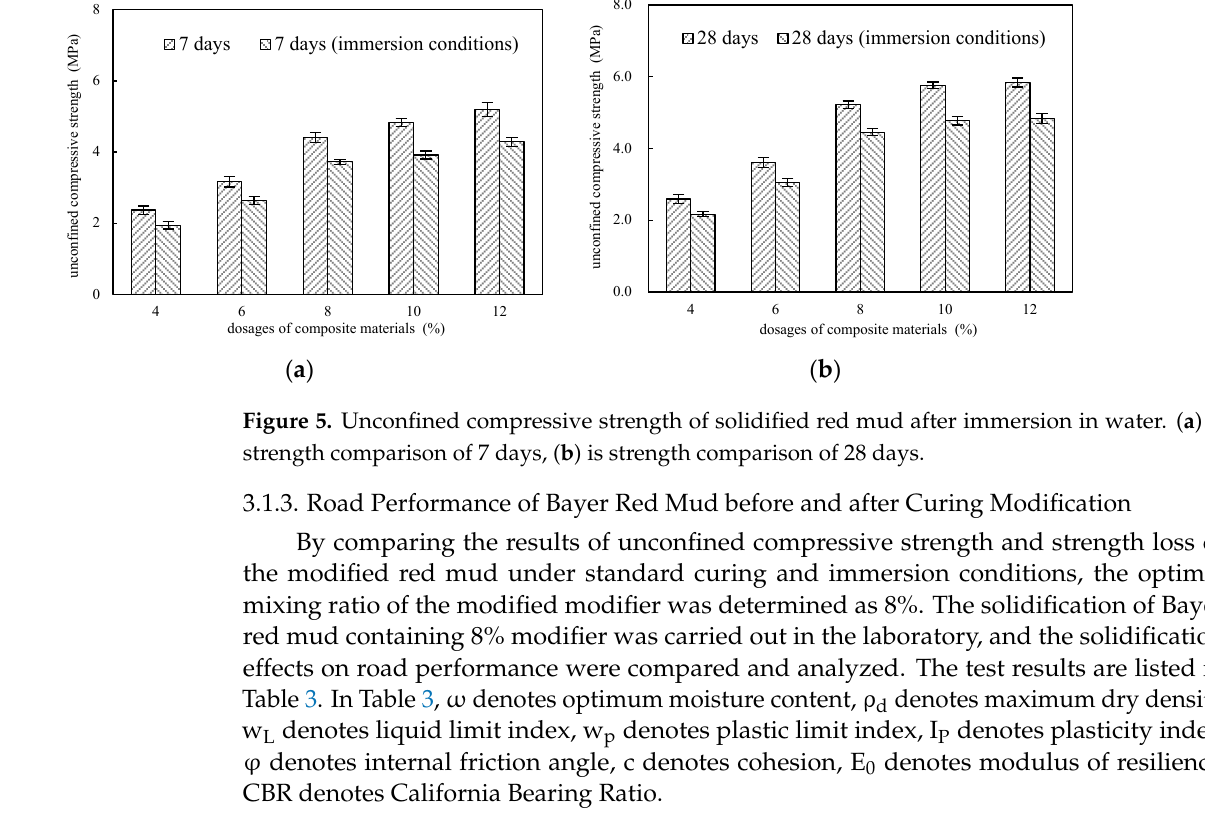
Table 3. Comparison of road performance of Bayer red mud before and after curing modification.